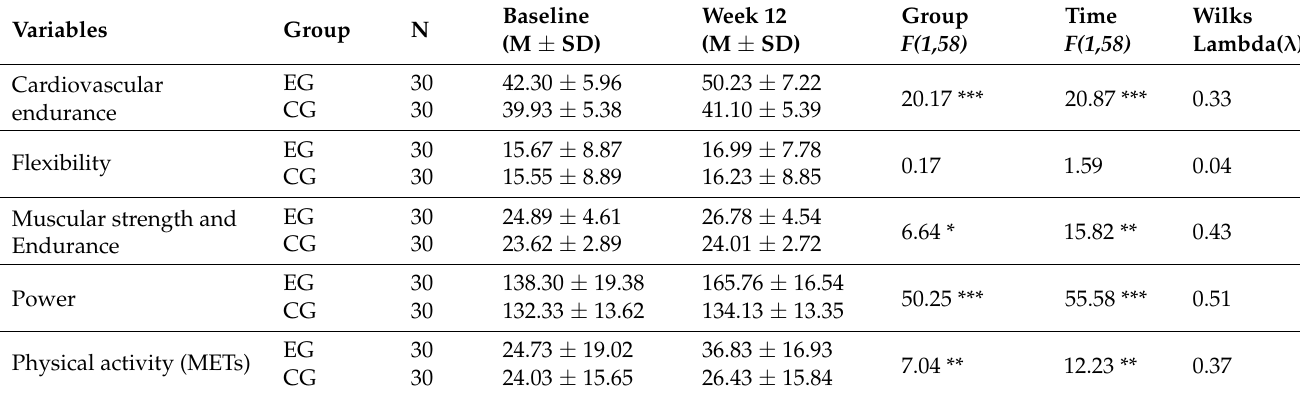
Table 4. Changes in physical fitness and physical activity over the